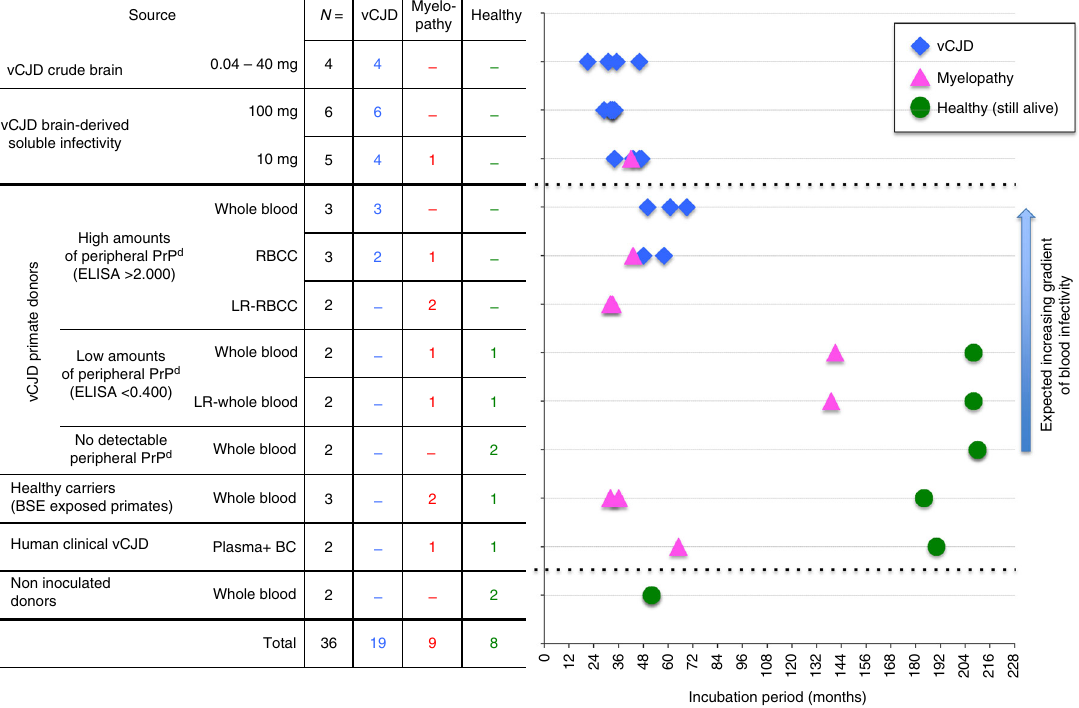
Fig. 8 Classi fi cation of recipient primates depending upon the blood inocula. Primates were exposed through the intravenous route to whole blood or red blood cell concentrates (RBCC), deleukocyted (LR) or not (each time the equivalent of 40 ml of whole blood). The blood products were classi fi ed according to the species (primate/human) and the status with regard to peripheral vCJD replication (no, low or high levels of peripheral PrP res , or unknown status in subclinical donors depicted here as healthy carriers). The recipient animals are categorised according to the disease phenotypes they developed and